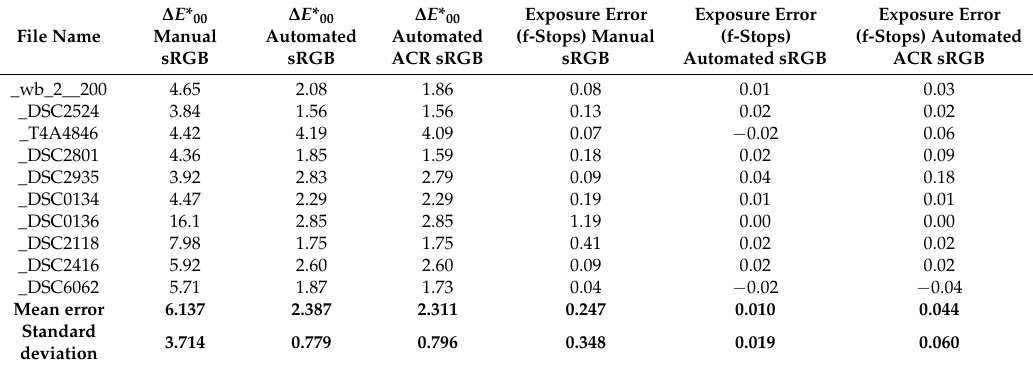
Table 2. ∆ E * 00 evaluation.